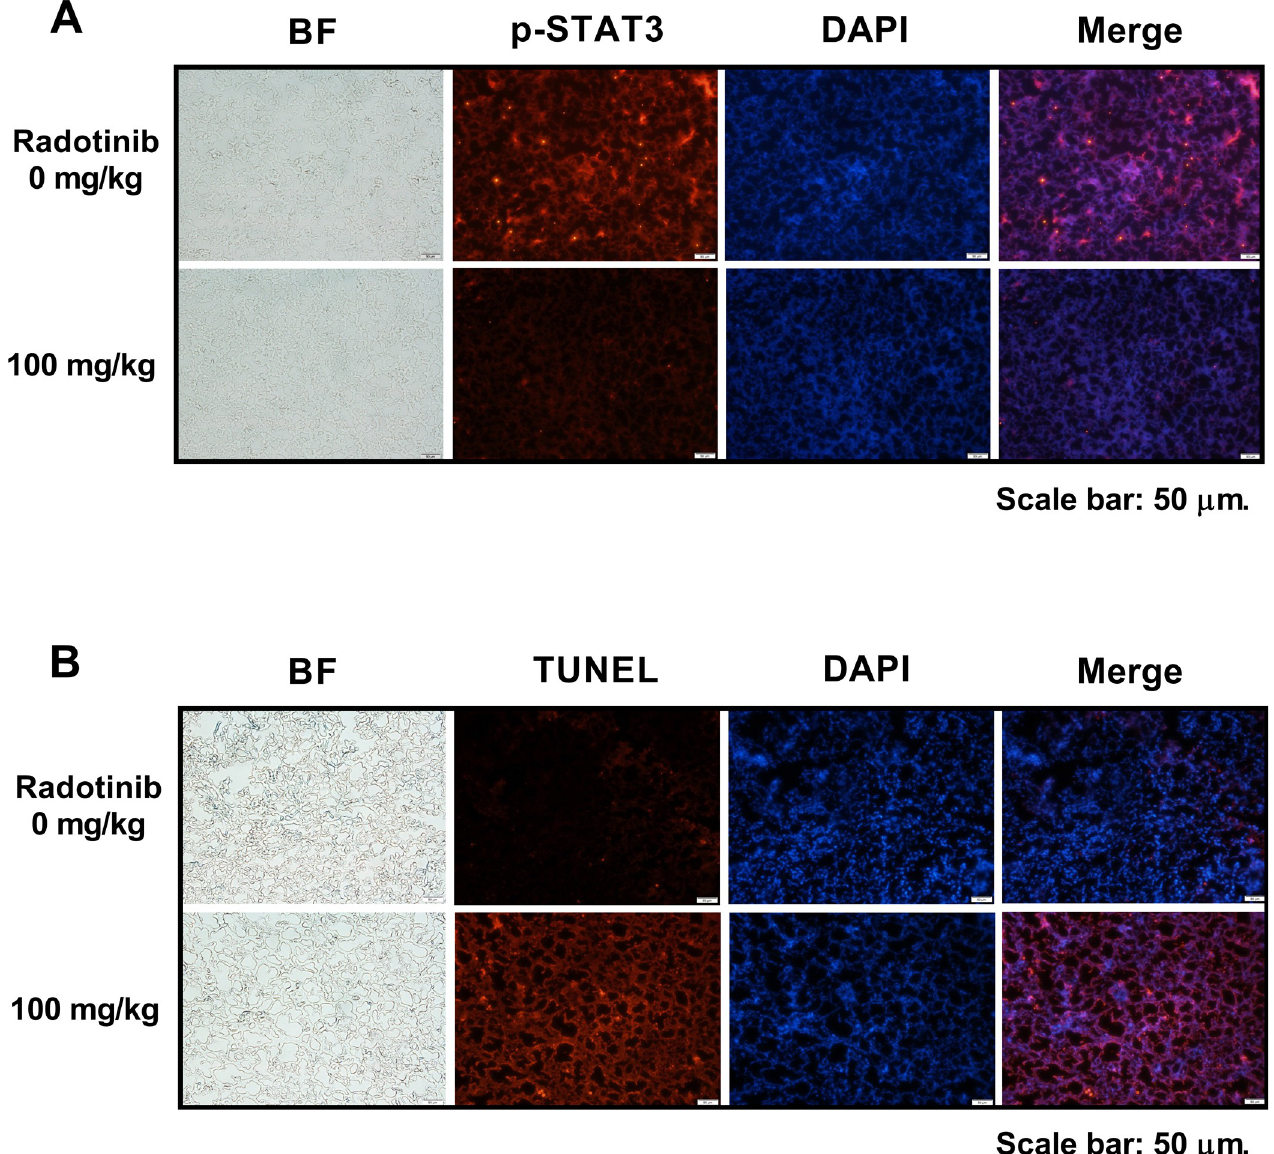
Fig 6. The effects of radotinib on the p-STAT3 and TUNEL positive cells expression in tumor tissue. (A) Measurement of p-STAT3 expression in tumor tissue. Radotinib significantly decreased the p-STAT3 expression in tumor tissue. Upper panel, radotinib 0 mg/kg; lower panel, radotinib 100 mg/kg. (B) Measurement of DNA double-strand breaks in tumor tissue. Radotinib significantly increased the DNA double-strand breaks in tumor tissue. TUNEL assay was used for measurement of DNA double-strand breaks in tumor tissue as described in the Methods. Upper panel, radotinib 0 mg/kg; lower panel, radotinib 100